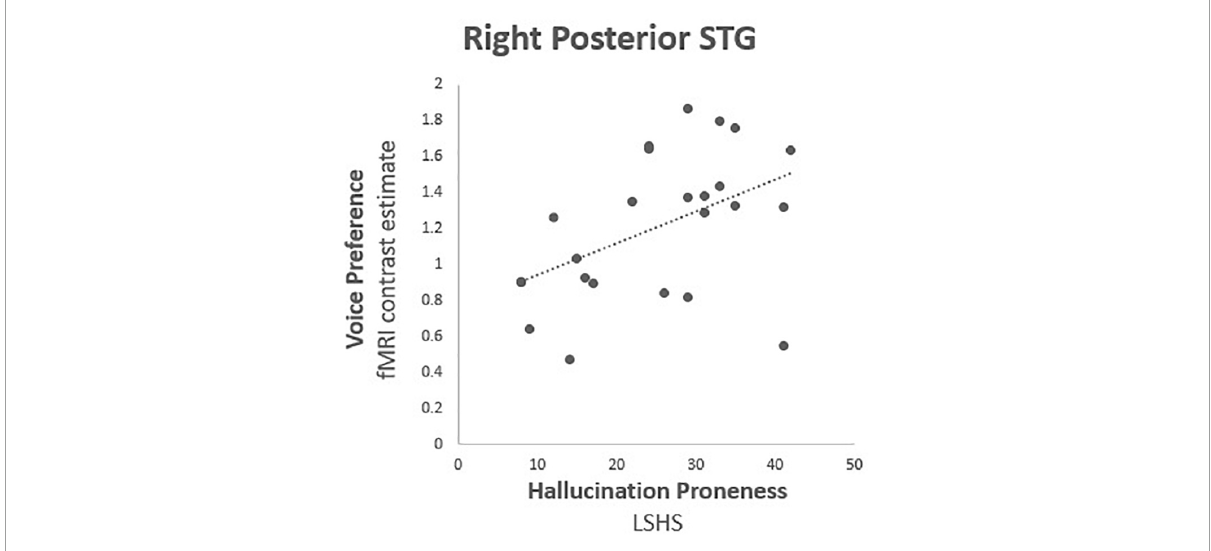
FIGURE2 Hallucination proneness fMRI correlation analysis results: Right posterior superior temporal gyrus (BA 22; MNI 54, − 34, 4), Voice preference = contrast estimate [(Voice > Silence) > (Non-voice > Silence)], LSHS = Launay Slade Hallucination Proneness scale. Correlation coefficient r = 0.470, df = 25, p =